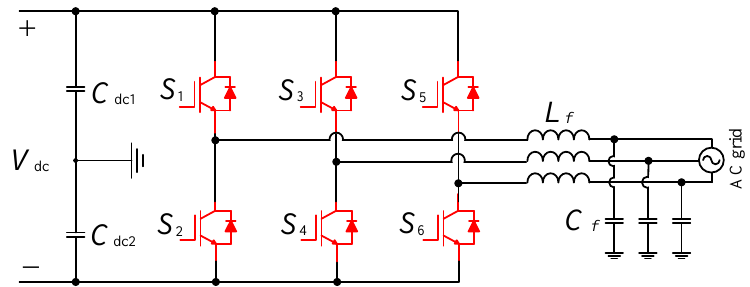
Figure 10. Bidirectional voltage source inverter (VSI) as the grid-interfaced converter.